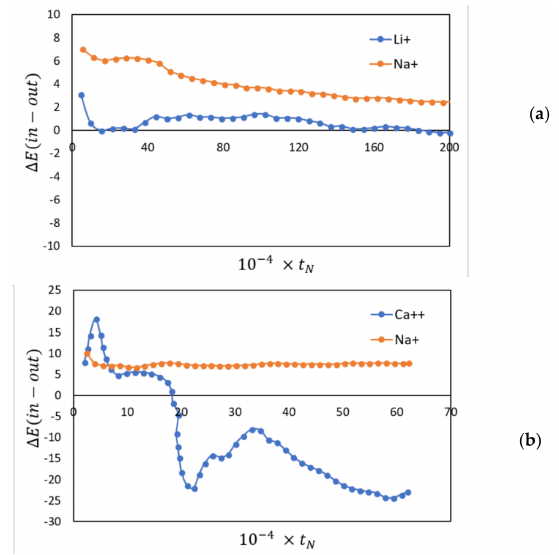
Figure 4. The differences in configurational energy of, Li + , Ca ++ and Na + ions (kJ/mol) inside and outside the membrane plotted against the number of time steps. A positive number indicates a preference for being outside the membrane. ( a ) Li + /Na + ; ( b ) Ca ++ /Na +